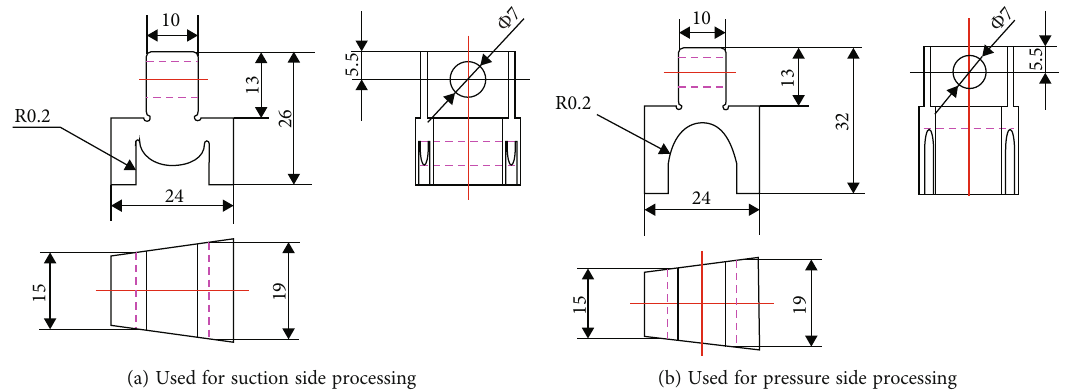
Figure 4: Layouts of electrode 702.